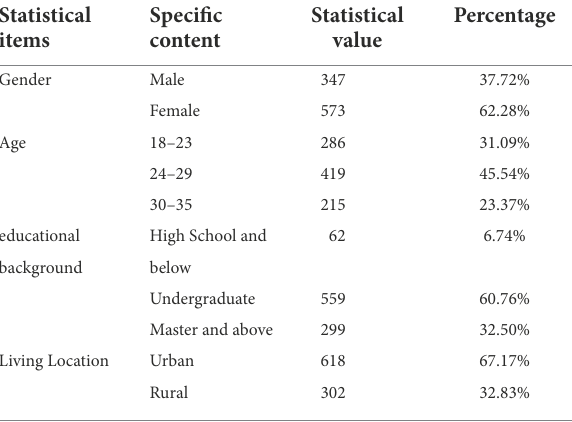
TABLE 2 Statistical table of basic information of effective